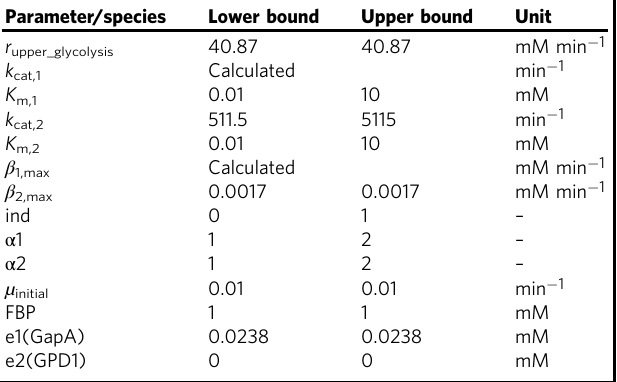
(Fig. 1e), we assumed a constant in fl ux in the model and fi xed the reaction rate in upper glycolysis to 4.9 mmol g − 1 h − 1 . This means that FBP is produced at a constant rate and it is either used for glycerol production or for growth according to the mass balances in Eq. (1).